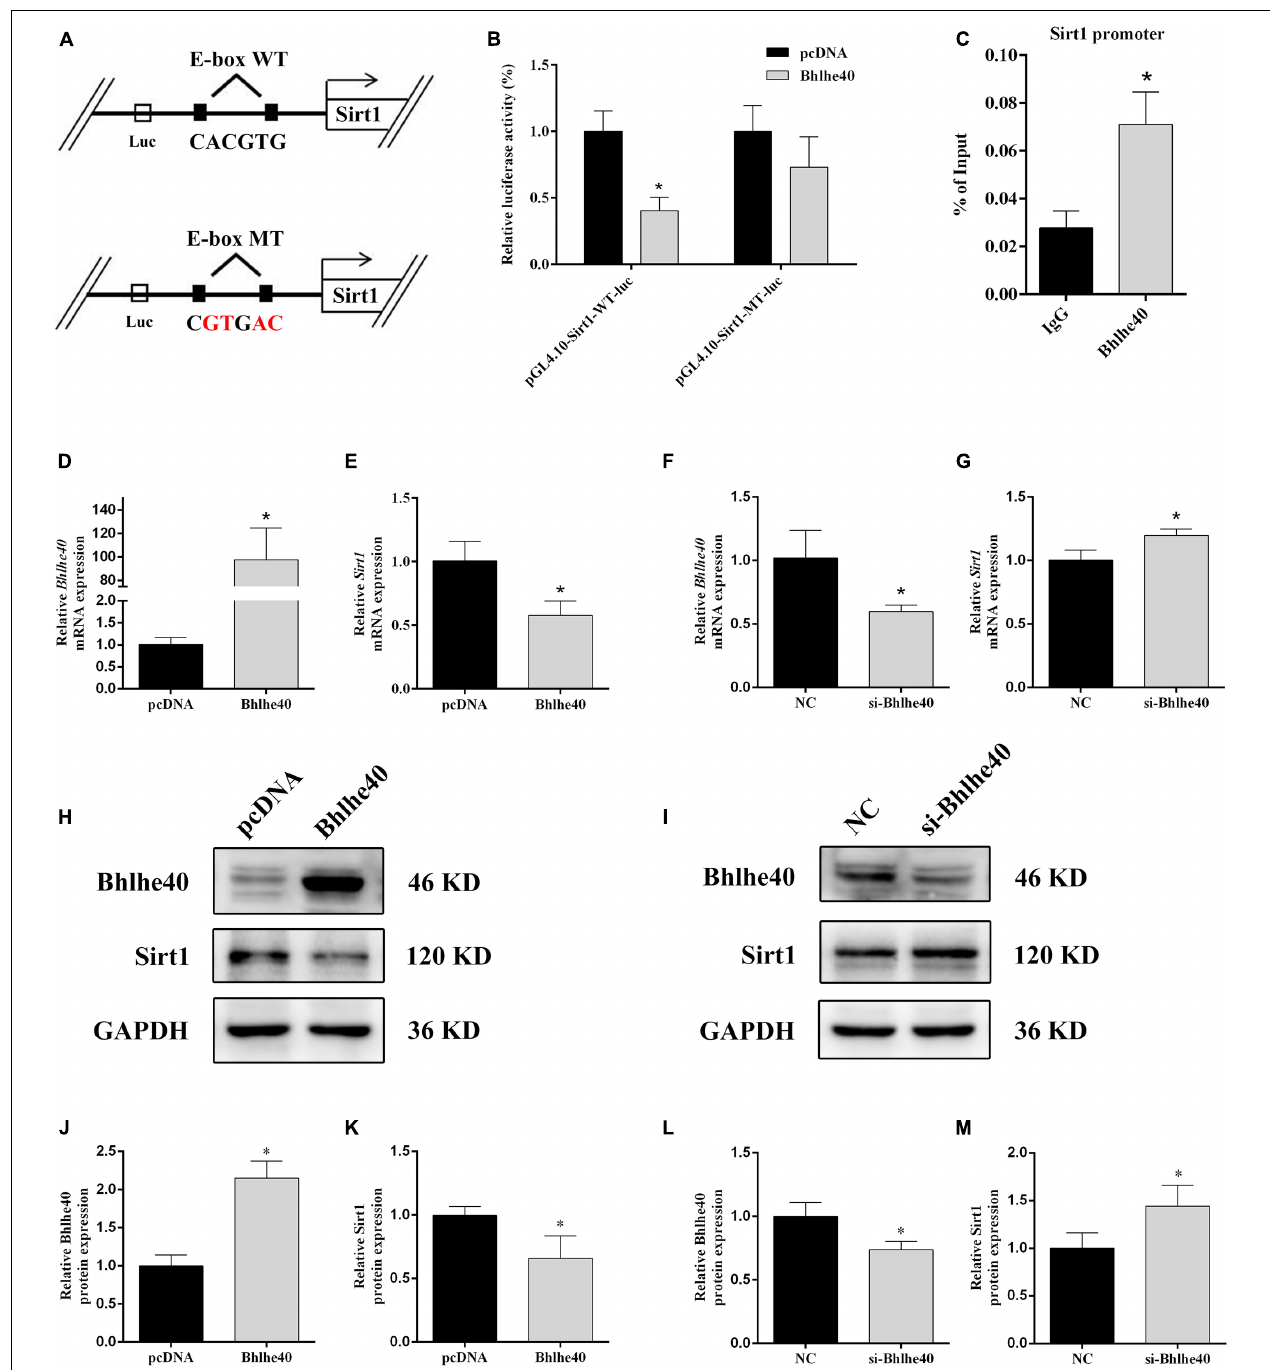
FIGURE 6 | Bhlhe40 negatively regulates Sirt1 . (A) Schematic representation of Sirt1 mRNA depicting Bhlhe40-binding sites in its promoter. (B) Luciferase reporter assays were conducted using a Sirt1 promoter with deleted E-box motifs after C17.2 cells were transfection with pcDNA or Bhlhe40 ( n = 3). Results are expressed as the mean ± SD. * p < 0.05 vs. Sirt1-promoter-WT-luc + pcDNA group. (C) Binding of Bhlhe40 to Sirt1 promoters was examined in C17.2 by ChIP assay. Results are expressed as the mean ± SD. * p < 0.05 vs. IgG group. (D) RT-qPCR analysis of the Bhlhe40 mRNA level in C17.2 cells transfected with pcDNA or Bhlhe40 ( n = 3). (E) RT-qPCR analysis of the Sirt1 mRNA level in C17.2 cells transfected with pcDNA or Bhlhe40 ( n = 3). (F) Western blot analysis of Bhlhe40 and Sirt1 protein levels in C17.2 cells transfected with pcDNA or Bhlhe40. (G) Quantitation of Bhlhe40 ( n = 3). (H) Quantitation of Sirt1 ( n = 3). Results are expressed as the mean ± SD. * p < 0.05 vs. pcDNA group. (I) RT-qPCR analysis of the Bhlhe40 mRNA level in C17.2 cells transfected with NC or si-Bhlhe40 ( n = 3). (J) RT-qPCR analysis of the Sirt1 mRNA level in C17.2 cells transfected with NC or si-Bhlhe40 ( n = 3). (K) Western blot analysis of Bhlhe40 and Sirt1 protein levels in C17.2 cells transfected with NC or si-Bhlhe40. (L) Quantitation of Bhlhe40 ( n = 3). (M) Quantitation of Sirt1 ( n = 3). Results are expressed as the mean ± SD. ∗ p < 0.05 vs. NC group.